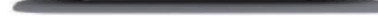
Figure 15. Intel realsense D455i.